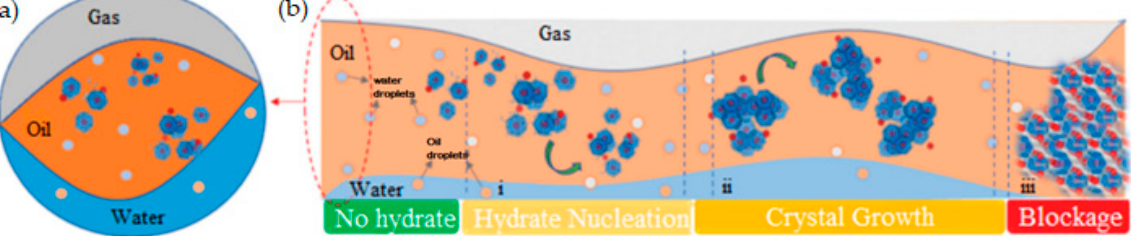
Figure 3. Schematic model of a multiphase flow in a pipeline, where hydrate crystal aggregates can flow in gaseous, oleic, and aqueous phases and/or deposit onto the pipe solid surface; ( b ) schematic diagram of the drivers of hydrate crystal formation and aggregation in hydrocarbon transportation pipelines and three-step process of ( i ) hydrate nucleation, ( ii ) crystal growth, and ( iii ) blockage. The transverse ( a ) and longitudinal ( b ) cross-section of the pipeline. Reproduced from Ref. [32]. Dissociation of gas hydrates can occur in multiphase systems during the flow of hy- drates in a water–oil–gas dispersed medium, because hydrate decomposition is influenced by the collision effect, including its own kinetic velocity, the effect of mass and heat transfer, and the nature of the multiphase flow of the oil and gas fluid. The kinetics of hydrate dissociation with respect to heat and mass transfer inside pipelines is important for the hydrate core/plug breakup, and it should be taken into account in predicting complications in oil pipeline transport (Figure 4)